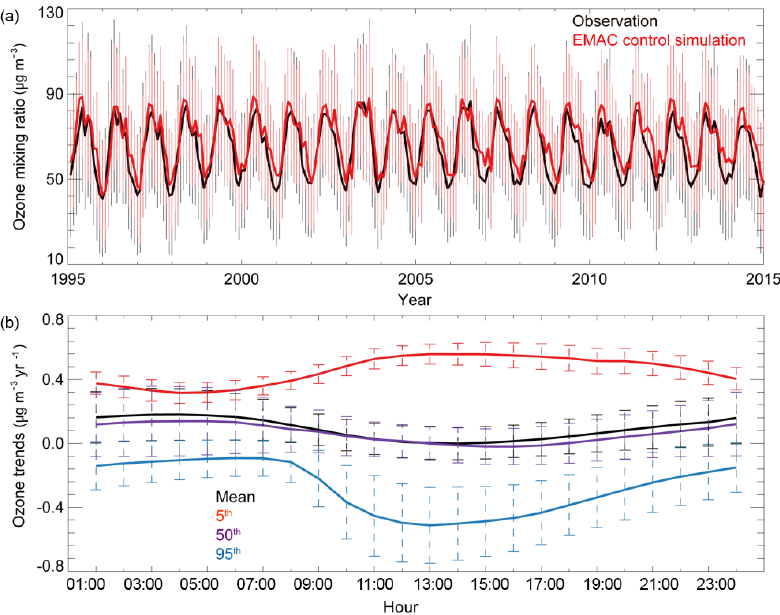
Figure 7. EMAC modeled ozone in µgm − 3 over Europe during 1995–2014. Time series of measured (black) and modeled (red) monthly mean ozone over the 93 selected sites (a) . Trend in the modeled surface ozone averaged over the selected 93 sites for all hours of the day (local time, b ). The black line shows the 1995–2014 linear trends in the European mean ozone, the red, purple, and blue lines are the modeled trends for 5th, 50th, and 95th percentile ozone, respectively. The dashed bars indicate their standard